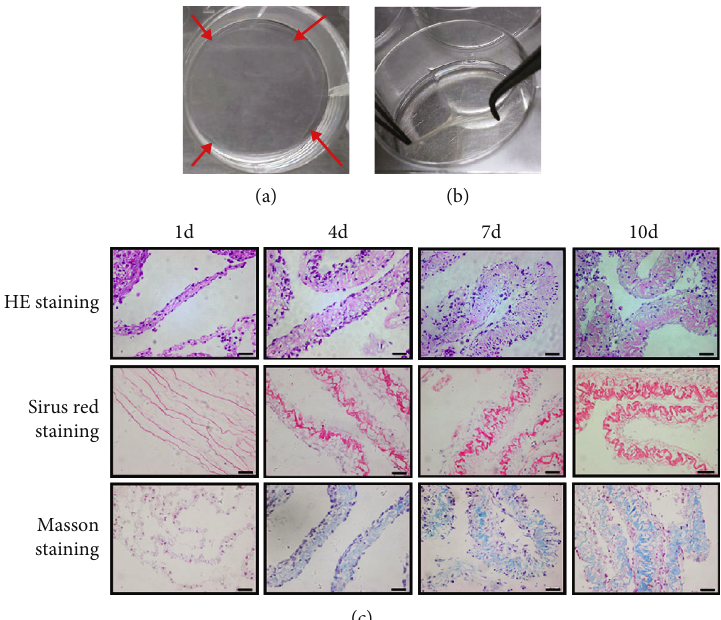
Figure 3: Morphological and histological staining of ASC sheets after the induction of vitamin C. (a) The edge of the ASC sheets began to curl slightly on day 7 of cell sheet induction (red arrows indicated the curly margins of ASC sheets). (b) ASC sheets could be easily detached by tweezers. (c) Histological staining of ASC sheets on days 1, 4, 7, and 10 of cell sheet induction, respectively. By HE staining, the cell nuclei were dyed blue and the collagen fi bers pale pink. By Sirius Red staining, the collagen fi bers were dyed red, and by Masson staining, the collagen fi bers were stained blue. Scale bars: 20 μ